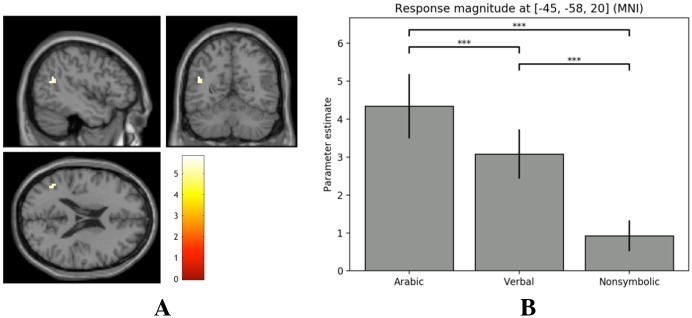
MTG cluster activity and response magnitudes.(A) Slices illustrate MTG cluster activity at z = 20 across conditions (p < 0.05 FWE). (B) Average parameter estimates for this cluster across conditions.